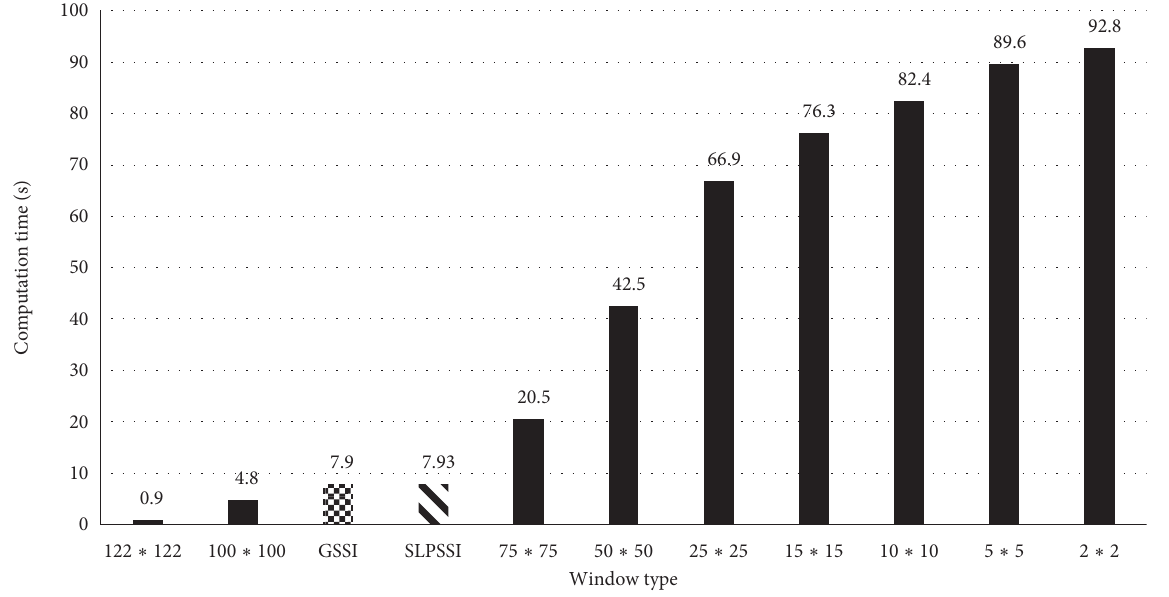
Figure 13: Comparison of computational time of different